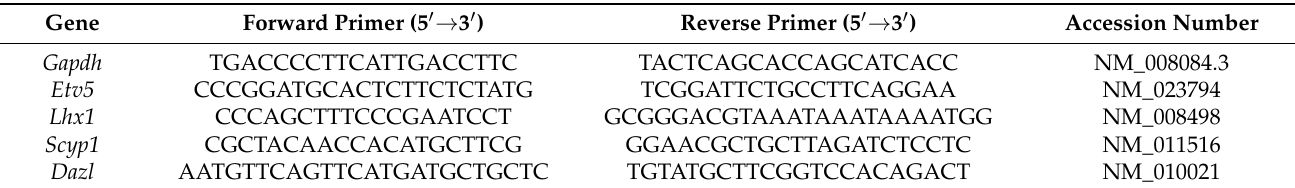
Table 3. RT-qPCR